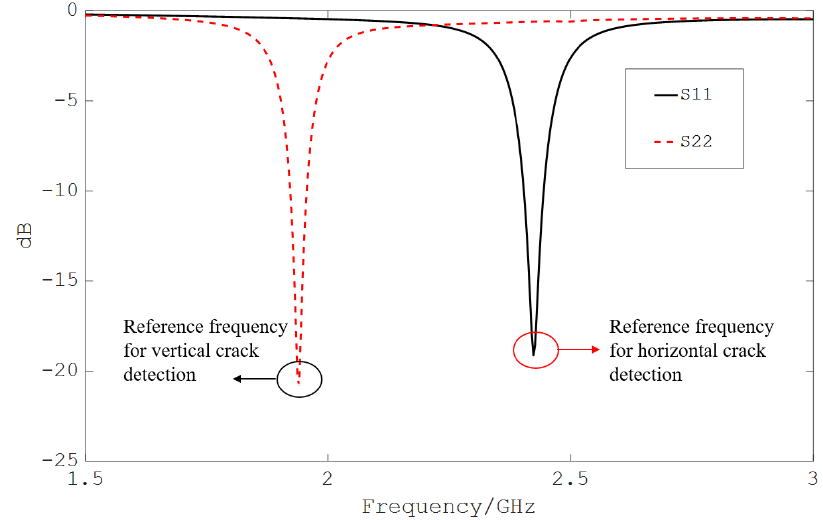
Figure 7. Simulated reflection coefficients of the sensor for the case without cracks.